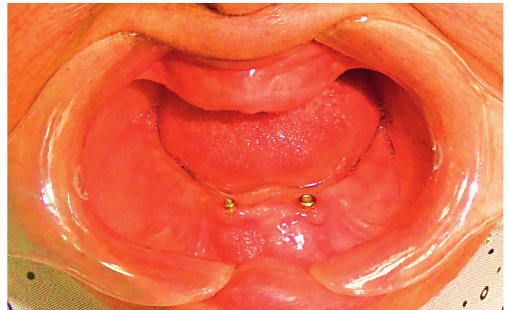
Figure 3: OT Equator (left) and Locator (right) abutments mounted